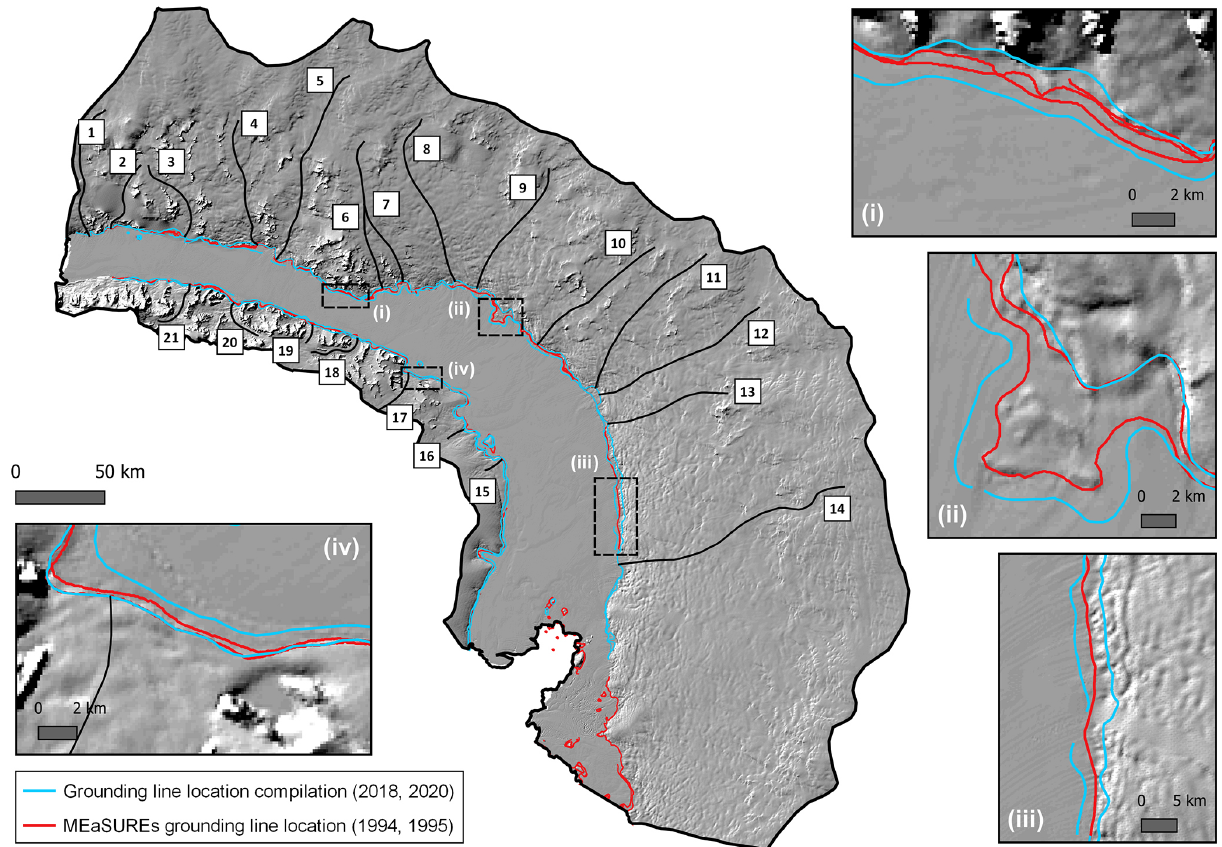
Figure A1. Landward (high-tide) and seaward (low-tide) limits of the modern-day (2018–2020) grounding line (blue) and the position of the grounding line in the mid-1990s (red). Background hillshade is derived from the Reference Elevation Model of Antarctica (Howat et al., 2019). Dashed boxes denote the location of the inset boxes